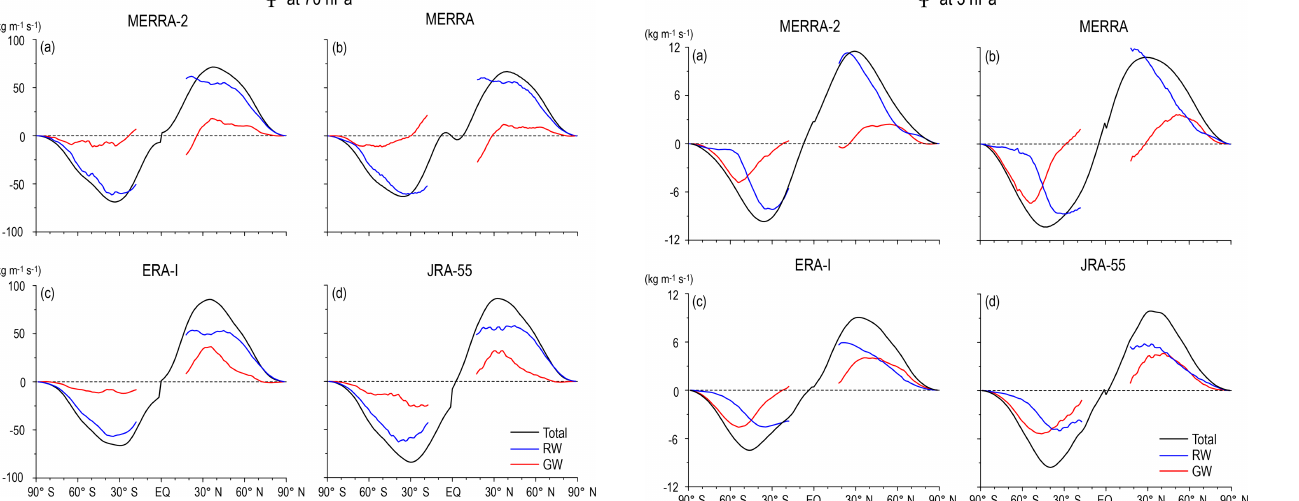
(cid:57) (φ,z) , (cid:57) RW (φ,z) , and (cid:57) GW (φ,z) among the four reanal-